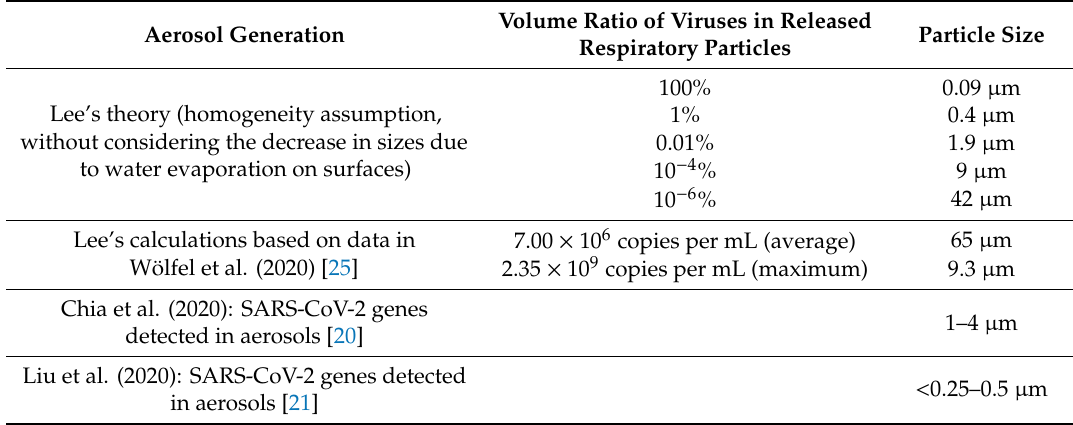
Table 1. Minimum size of particles potentially carrying SARS-CoV-2.